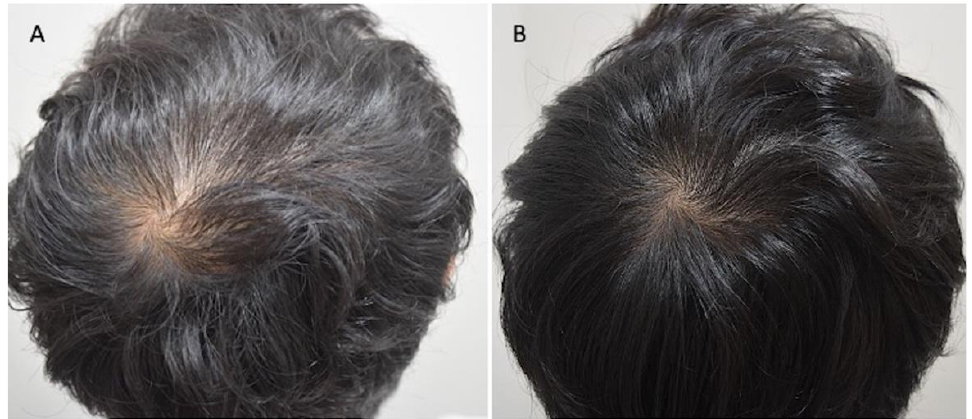
Figure 3. Asian male patients treated with MND and LLLT protocols. ( A ) Pre-operative view of the scalp of a 29-year-old male patient affected by AGA III-vertex according to Norwood – Hamilton scale with hair loss localized in the frontal, temporal, parietal, and vertex area; ( B ) post-operative view at T1-16 wks after MND and LLLT treatment with detail of HR-G in vertex area.